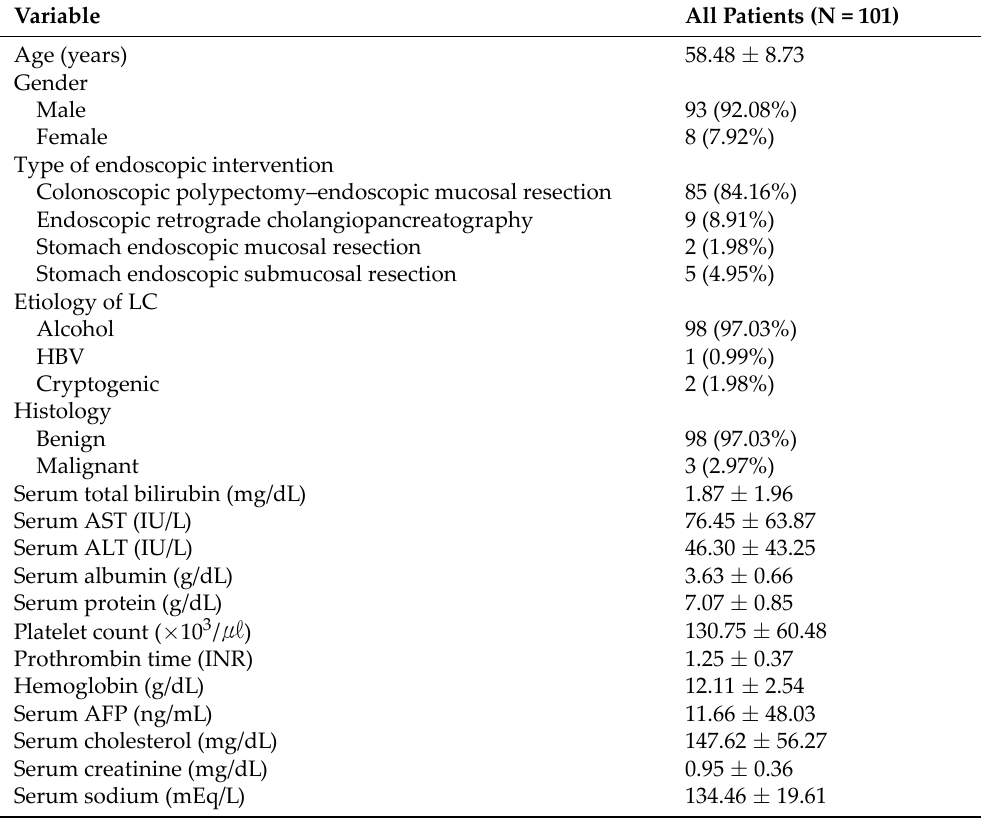
Table 1. Clinical characteristics of patients with liver cirrhosis who underwent the endoscopic procedure.